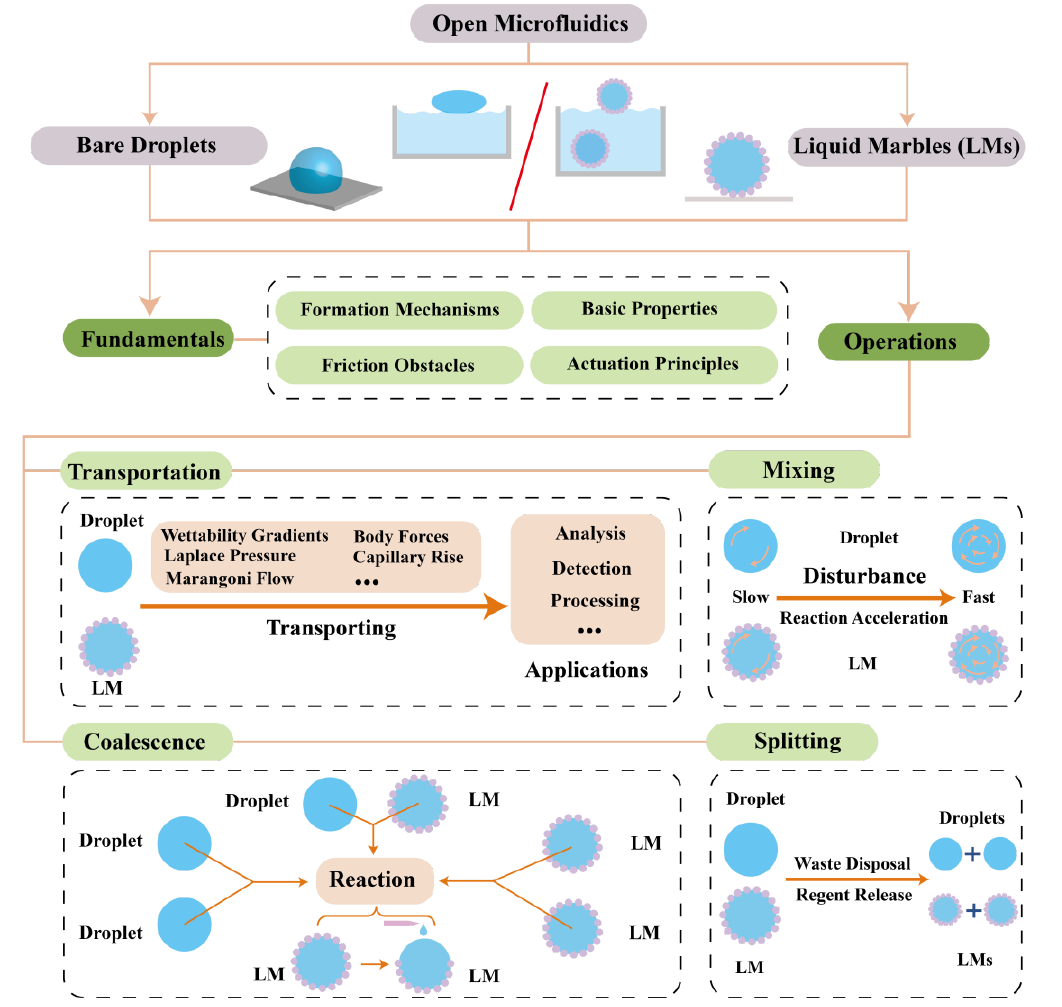
Figure 1. The research strategy for fundamentals and operations of bare droplets and LMs in OMF. The discussion on the fundamentals of bare droplets and LMs mainly involves their formation mechanisms, basic properties, friction obstacles and actuation principles. The operation tasks of droplets and LMs can be divided into four types based on specific functions: transportation for transferring objects simply, coalescence for merging two isolated samples, mixing for blending different contents in reactions and splitting for cutting an origin sample into multi-samples.